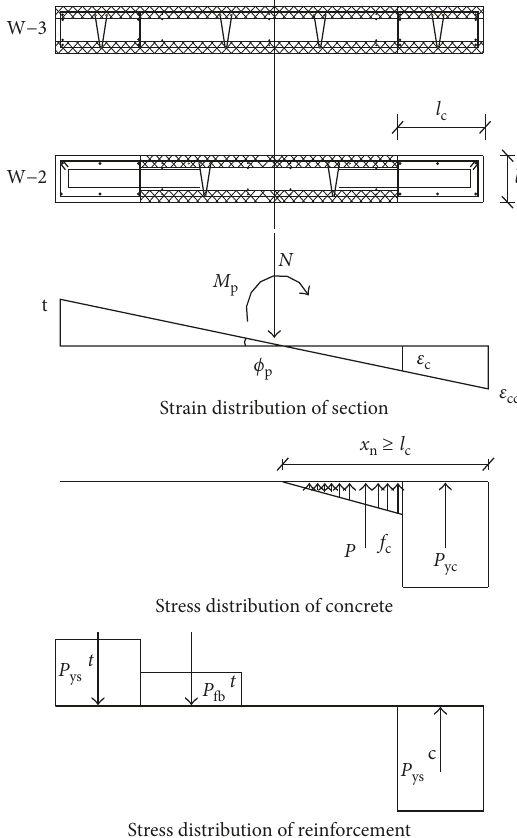
Figure 29: The stress-strain distribution of the